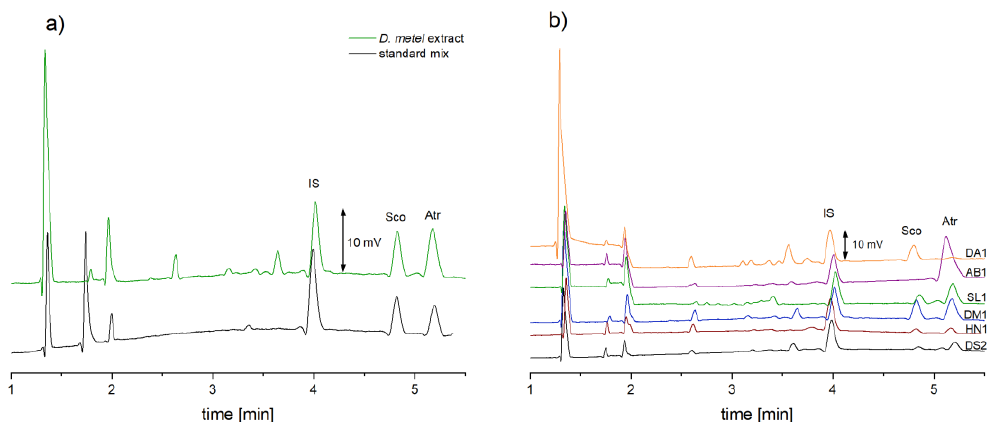
Figure 2. Electropherograms for the analysis of ( a ) mix of standards and D. metel seeds extract, ( b ) extracts of seeds (see Table 1): D. stramonium (DS2), H. niger (HN1), D. metel (DM1), S. lurida (SL1), A. belladonna (AB1), D. arborea (DA1). CE conditions: capillary length 29.9 cm (18.4 cm to the detector); applied voltage: + 11 kV; hydrodynamic injection (siphoning) 7 cm height for 30 s; BGE: 0.5 M acetic acid + 0.25% ( w/v ) β -CD. Table 1. Concentration ( μ g/g) of atropine and scopolamine in Solanaceae plants.